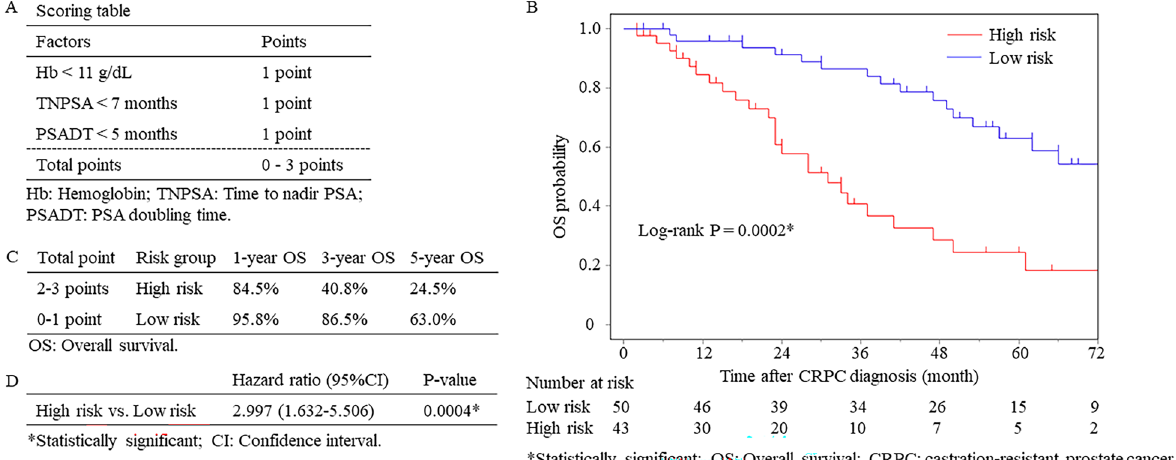
Figure 2. Kaplan–Meier curves according to the risk stratification ( A ) Scoring table for risk stratification ( B ) Kaplan Meier plot of overall survival stratified by risk groups ( C ) Overall survival according to the risk groups. ( D ) A hazard ratio of patients in the high-risk group.